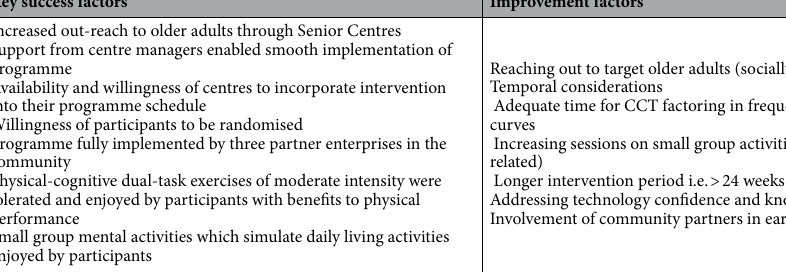
Table 7. Key findings of the multi-domain intervention